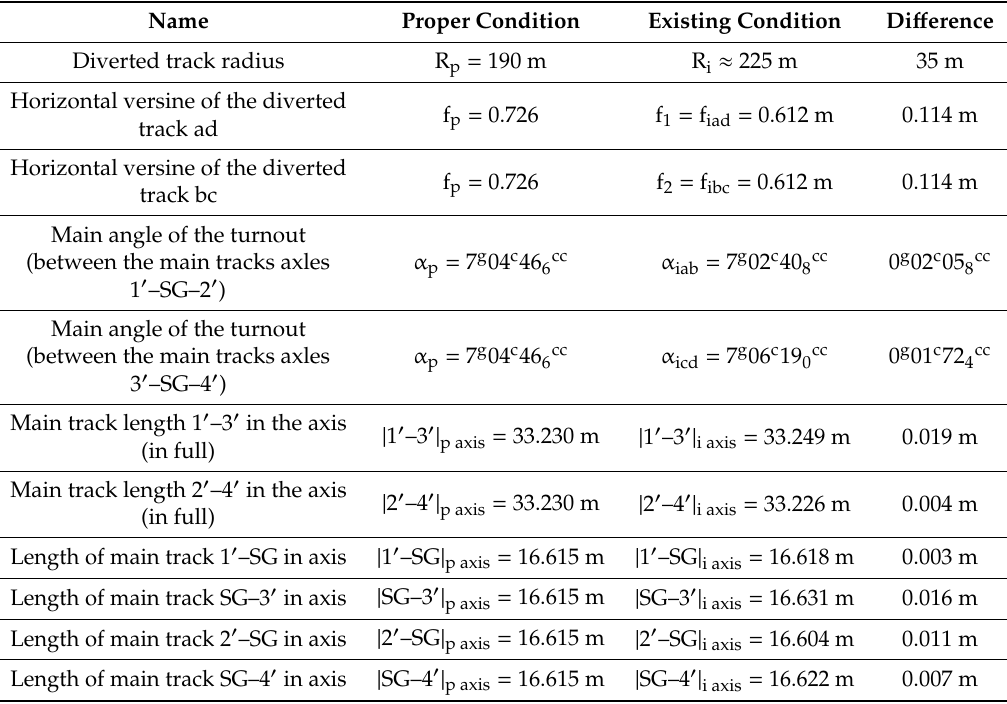
Table 1. Results of the measurements of the Rkpd iwew No. 9 ab / cd turnout type S49 / 1:9 / 190 while using the SMDOST